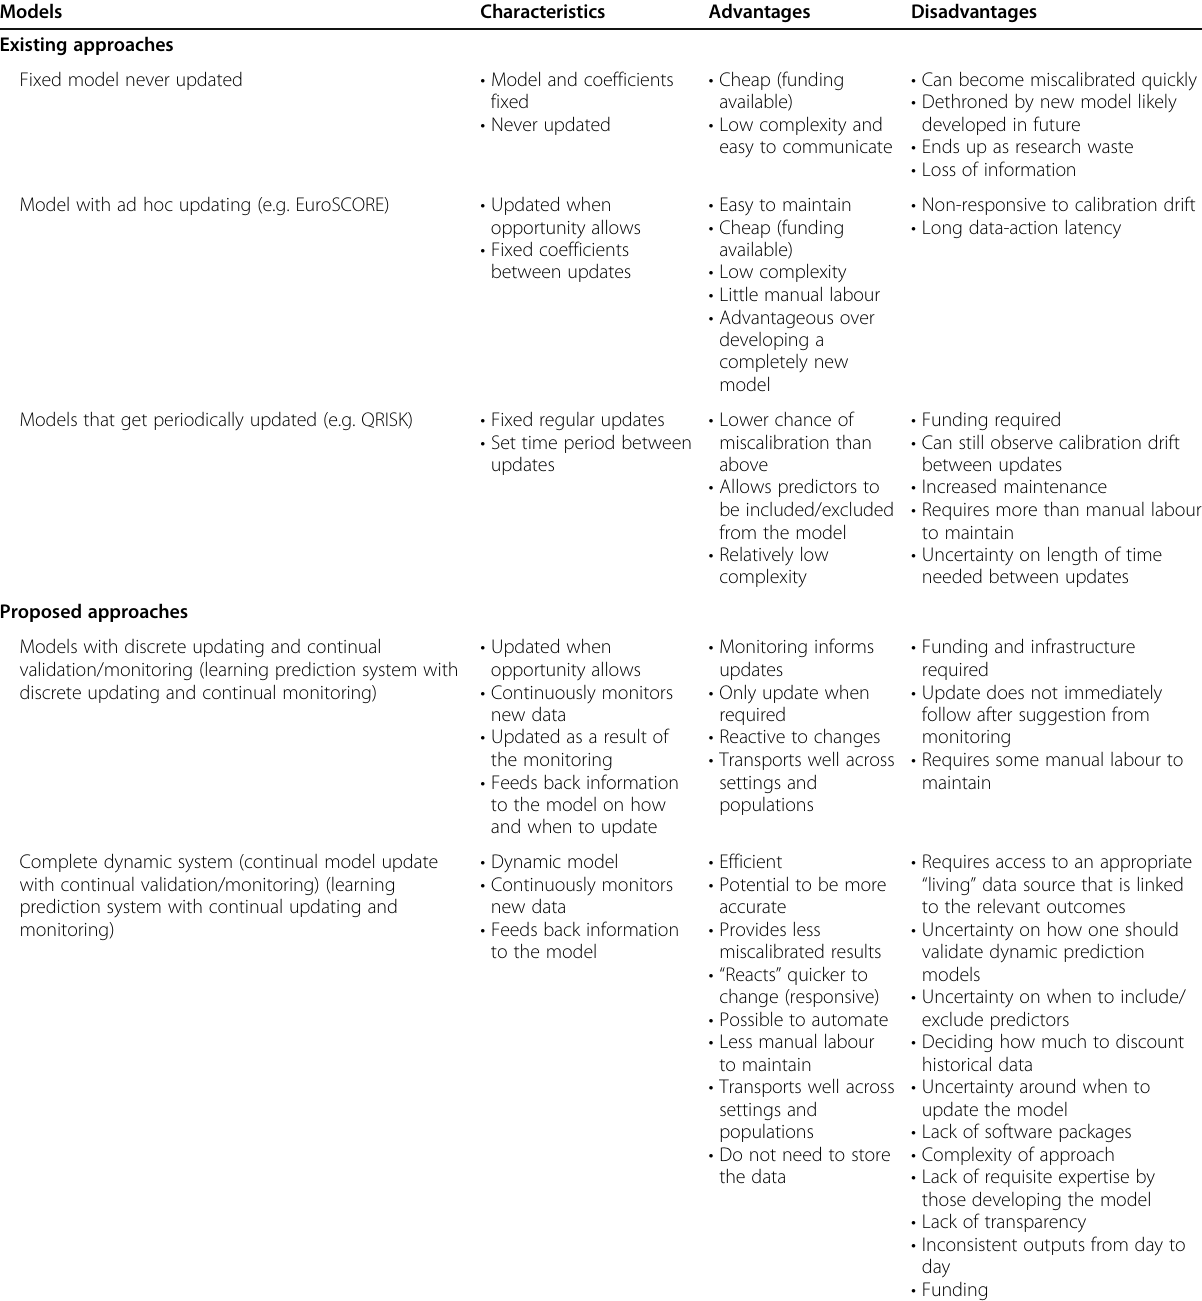
Table 1 Summary of the characteristics and pros and cons for different modelling approaches